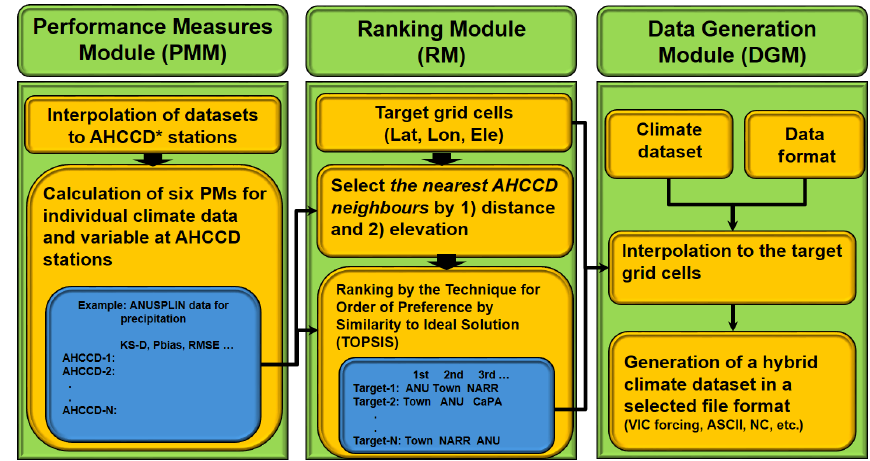
Figure 2. Structure of REFRES comprised of three modules: (1) performance measure module (PMM), (2) ranking module (RM), and (3) data generation module (DGM). Lat: latitude; Lon: longitude; Ele: elevation. ANU: ANUSPLIN; Town: Alberta Township. KS-D: Kolmogorov-Smirnov D statistic; NC: